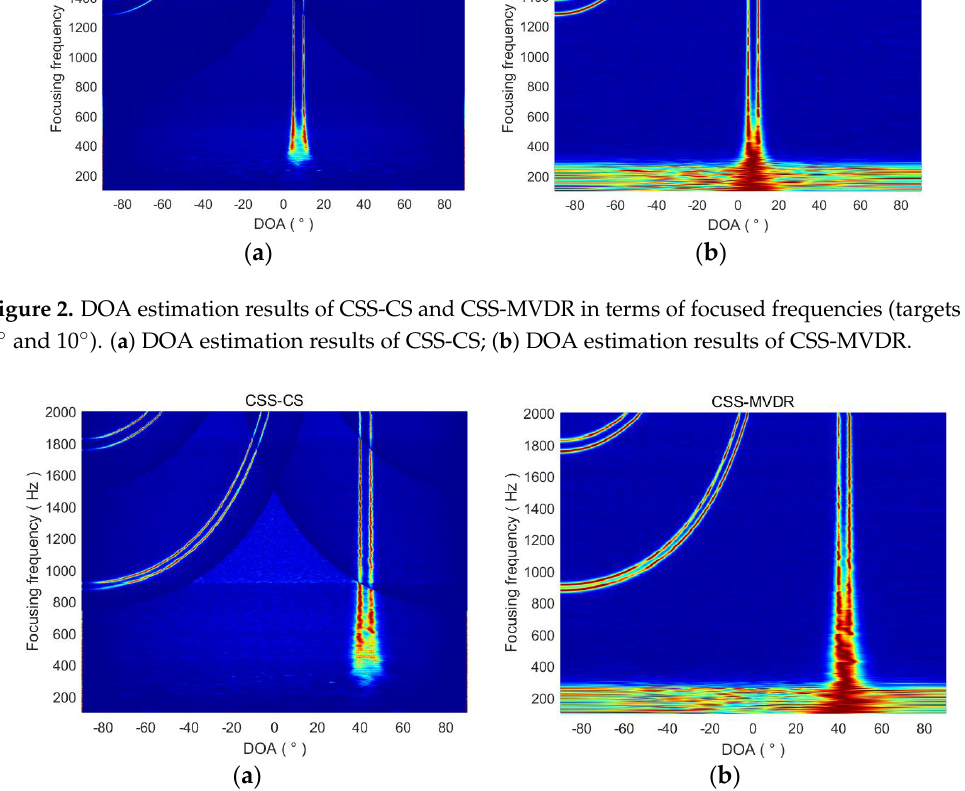
Figure 3. DOA estimation results of CSS-CS and CSS-MVDR in terms of focused frequencies (targets at 40° and 45°). ( a ) DOA estimation results of CSS-CS; ( b ) DOA estimation results of CSS-MVDR.